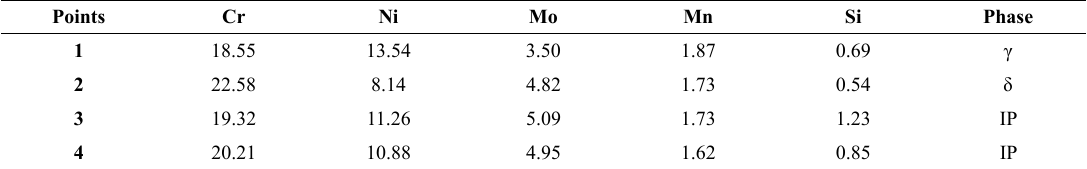
Table 11. Semi-quantitative chemical analysis determined by EDS of points selected in Figure 6(a) (wt%). (%Fe = balance).